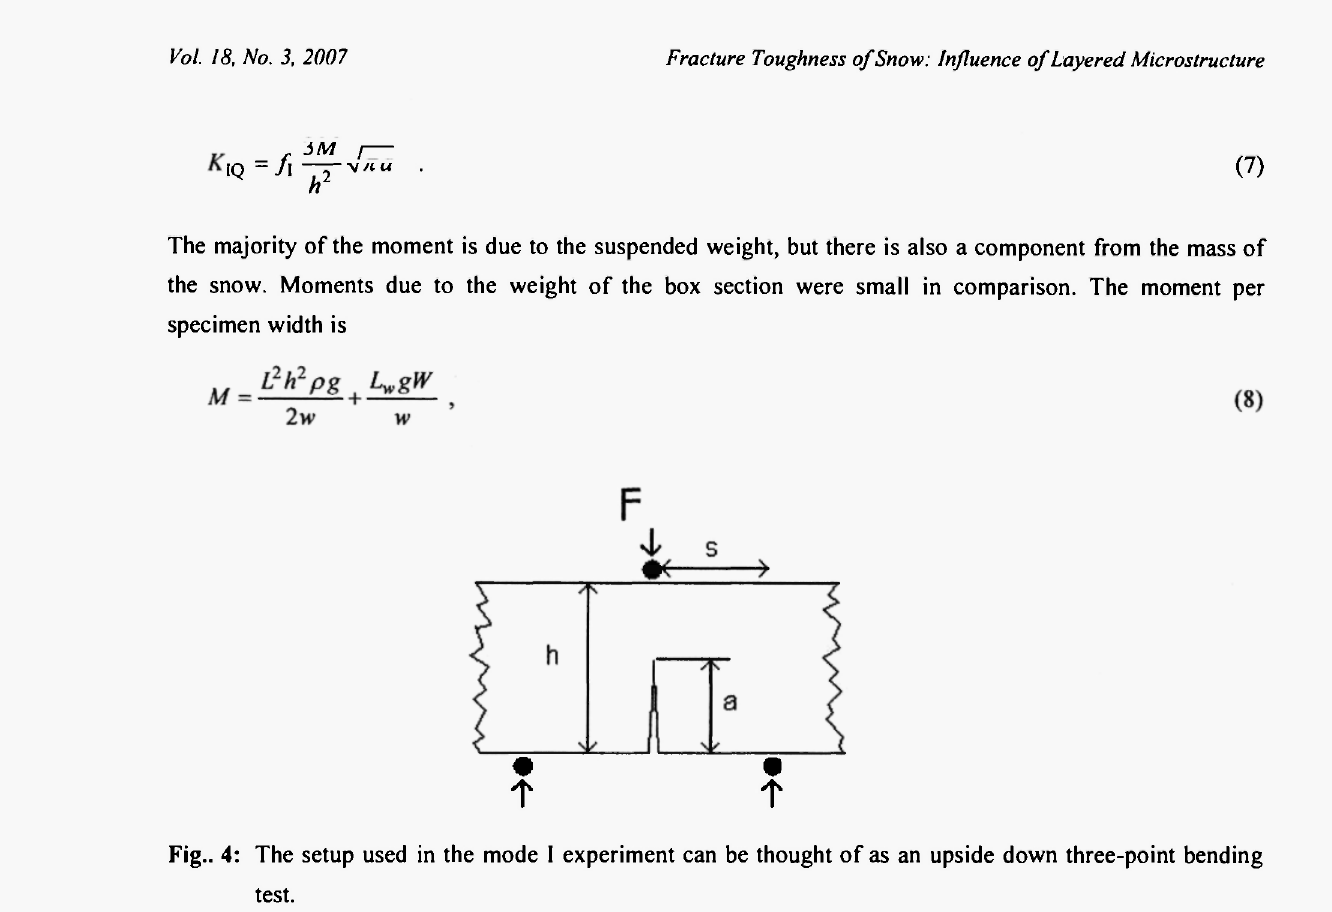
Fig.. 4: The setup used in the mode I experiment can be thought of as an upside down three-point bending